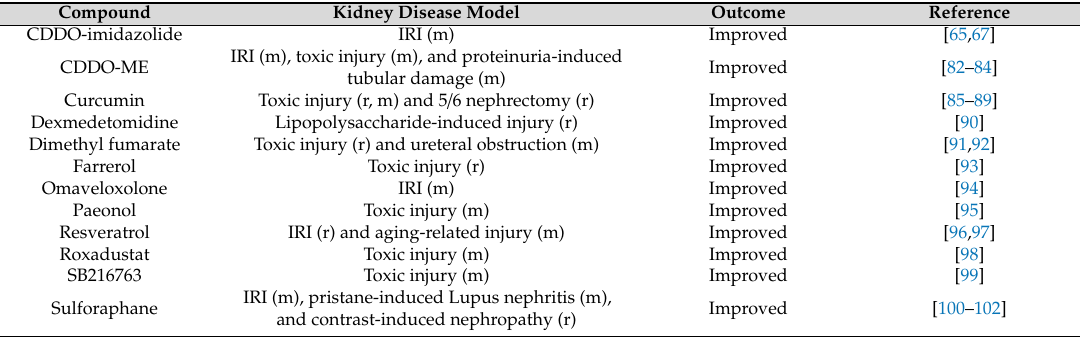
Table 2. Examples of Nrf2-activating reagents experimentally tested in kidney disease models. Compound Kidney Disease